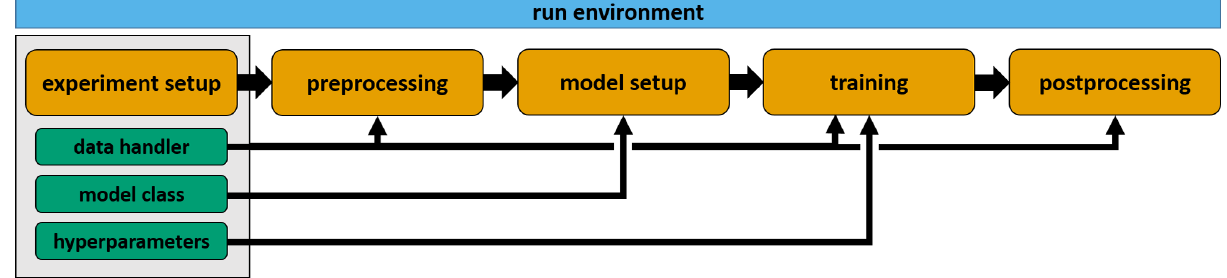
Figure 1. Visualization of the MLAir standard setup DefaultWorkflow including the stages ExperimentSetup , PreProcessing , ModelSetup , Training , and PostProcessing (all highlighted in orange) embedded in the RunEnvironment (sky blue). Each experiment customization (bluish green) like the data handler, model class, and hyperparameter shown as examples, is set during the initial ExperimentSetup and affects various stages of the